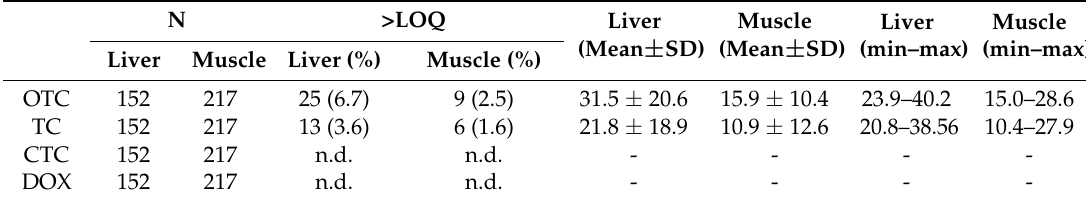
Table 2. Mean, range, and frequency of positive samples for tetracyclines (expressed in µ g kg − 1 ) of bovine samples examined. LOQ: limits of quantification.